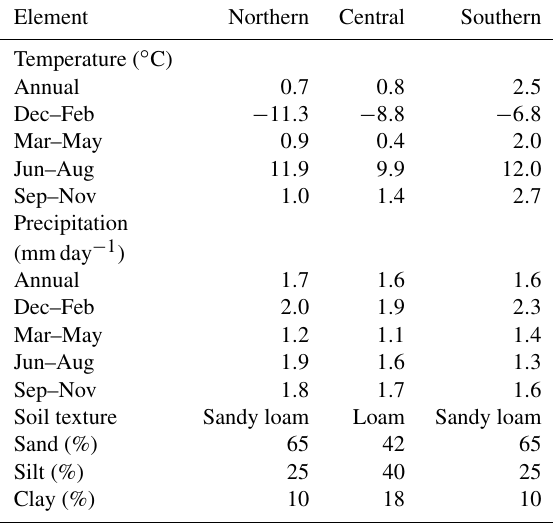
Table 1. Input climate data and soil texture for the three locations.